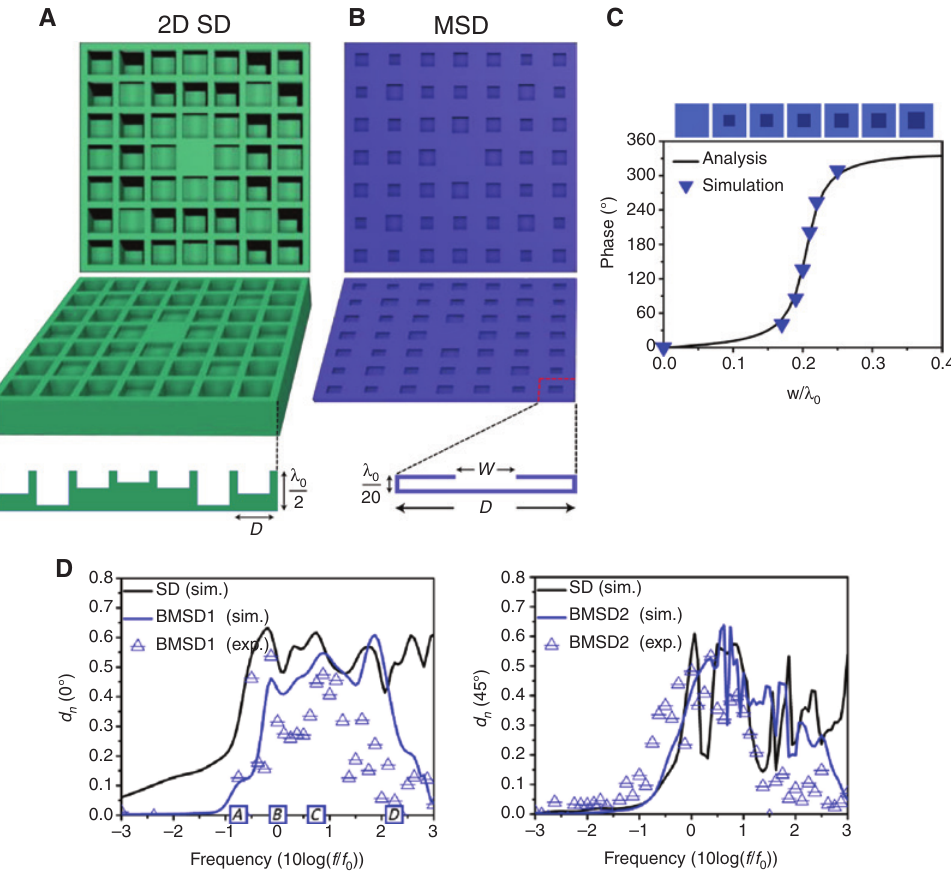
Figure 11: Comparison of traditional Schroeder diffusers and metasurface-based ultrathin Schroeder diffusers. (A) Schematics of a 2D Schroeder diffuser and (B) the proposed metasurface-based Schroeder diffuser. (C) The analytical and simulated relationship between the phase shift and the geometrical parameter w at the center frequency of 6860 Hz. (D) Simulated and measured diffusion coefficient for 0 ° (left) and 45 ° (right) in the x - z plane versus frequency for broadband metasurface-based Schroeder diffuser and Schroeder diffuser, respectively (reprinted from Ref.